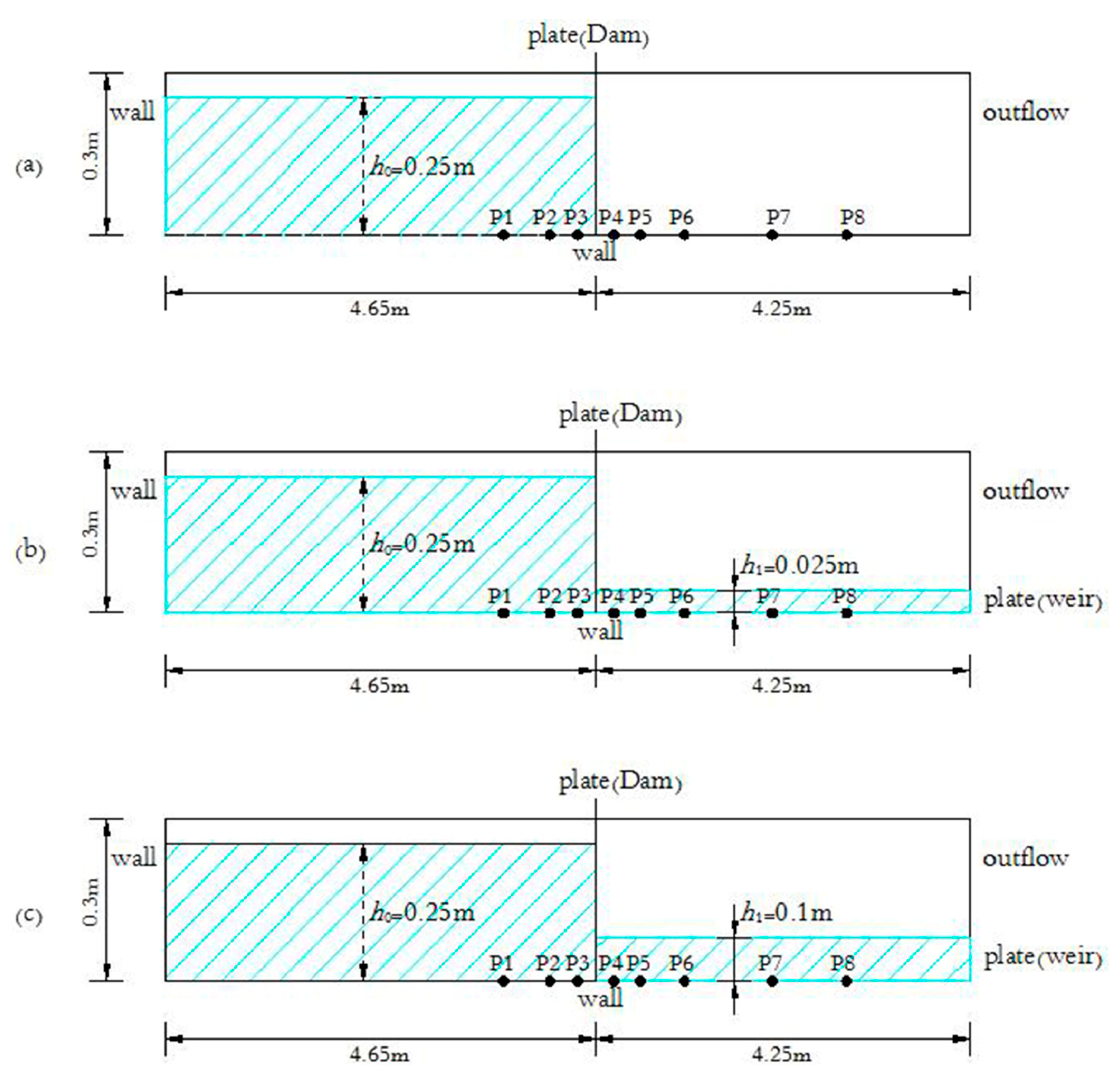
Figure 1. Schematic view of the experimental conditions by Ozmen ‐ Cagatay and Kocaman [30]: ( a ) α = 0; ( b ) α = 0.1; and ( c ) α = 0.4.